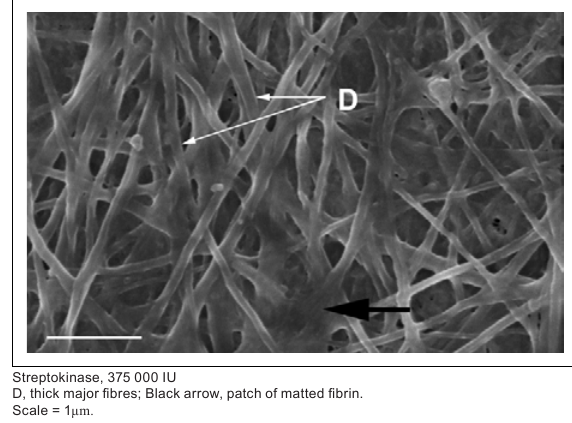
FIGURE 1 Scanning electron microscope image of control dog fibrin network with thick, major fibres as